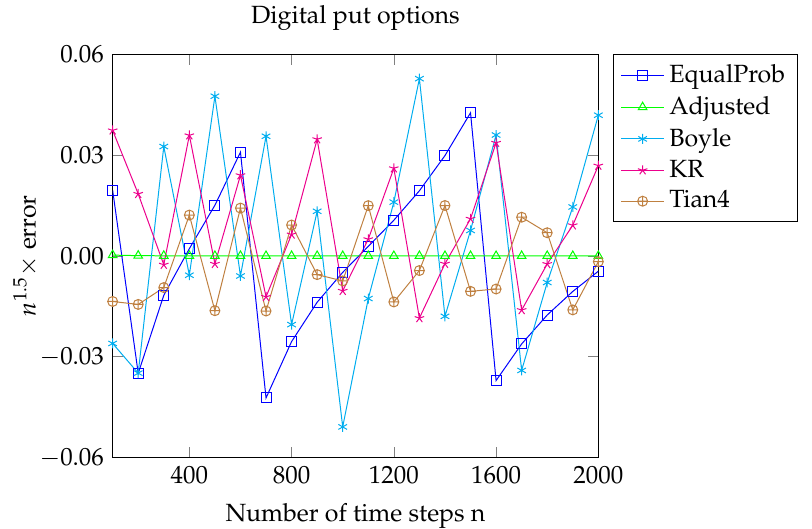
Figure 4. Here, S = 100, K = 105, r = 0.05, σ = 0.2 and T = 1. For the digital put, the Black–Scholes price P BS = 0.511215. P d ( n ) is the n -period price calculated by various models, and error = P d ( n ) − P BS − e − rT φ ( d 2 ) this again appears to be the